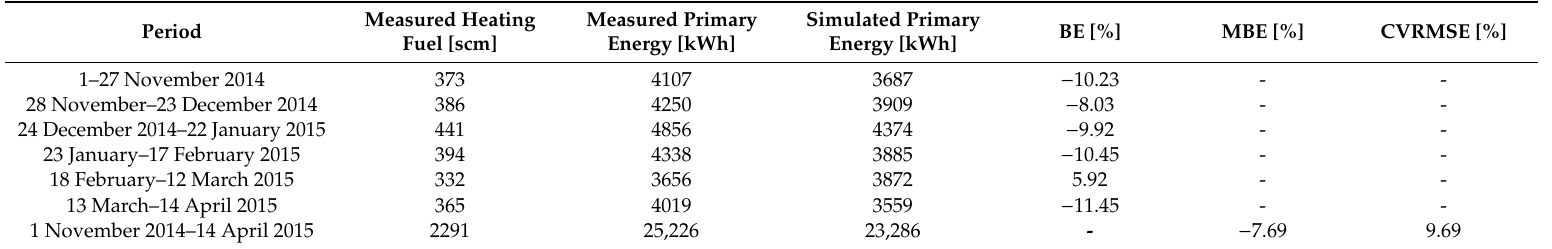
Table 16. Monthly and seasonal heating fuel consumption as measured from bills and as simulated with MCM.